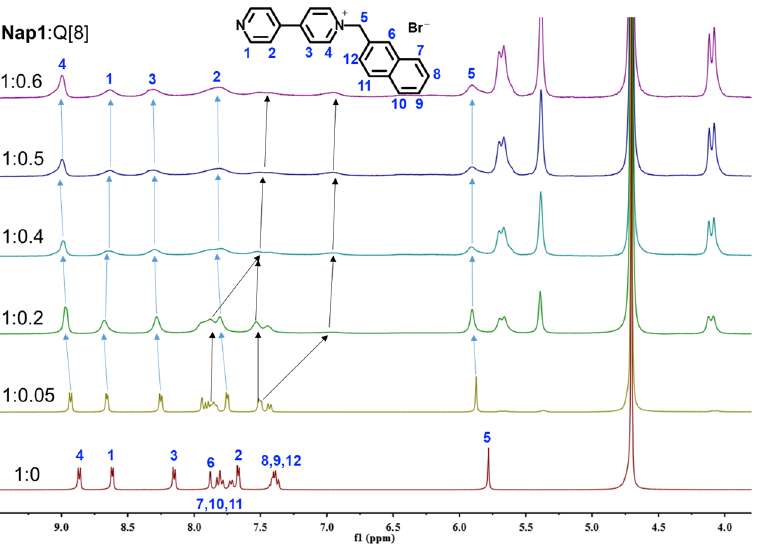
Figure 1. 1 H NMR spectrum (400 MHz) of the mixtures of Nap1 (1.0 mM) and Q[8] (0 to 0.6 equiv) in D 2 O at 25 °C.